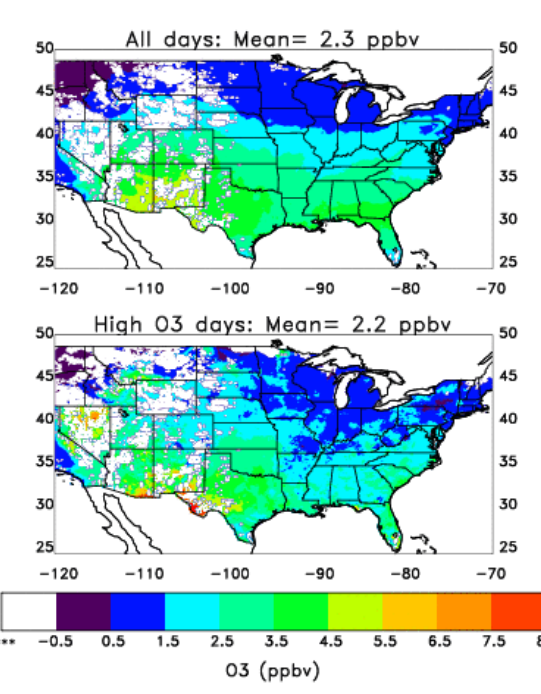
Figure 10. Mean increase in 8-hour maximum ozone associated with lightning-NO Fig. 10. Mean increase in 8-h maximum ozone associated with production during the 1 June through 31 August time period. Results averaged over all lightning-NO production during the 1 June through 31 August time days (top) and over days when 8-hr maximum ozone from simulation noL exceeds 60 period. Results averaged over all days (top) and over days when 8-h ppbv (bottom). maximum ozone from simulation noL exceeds 60ppbv